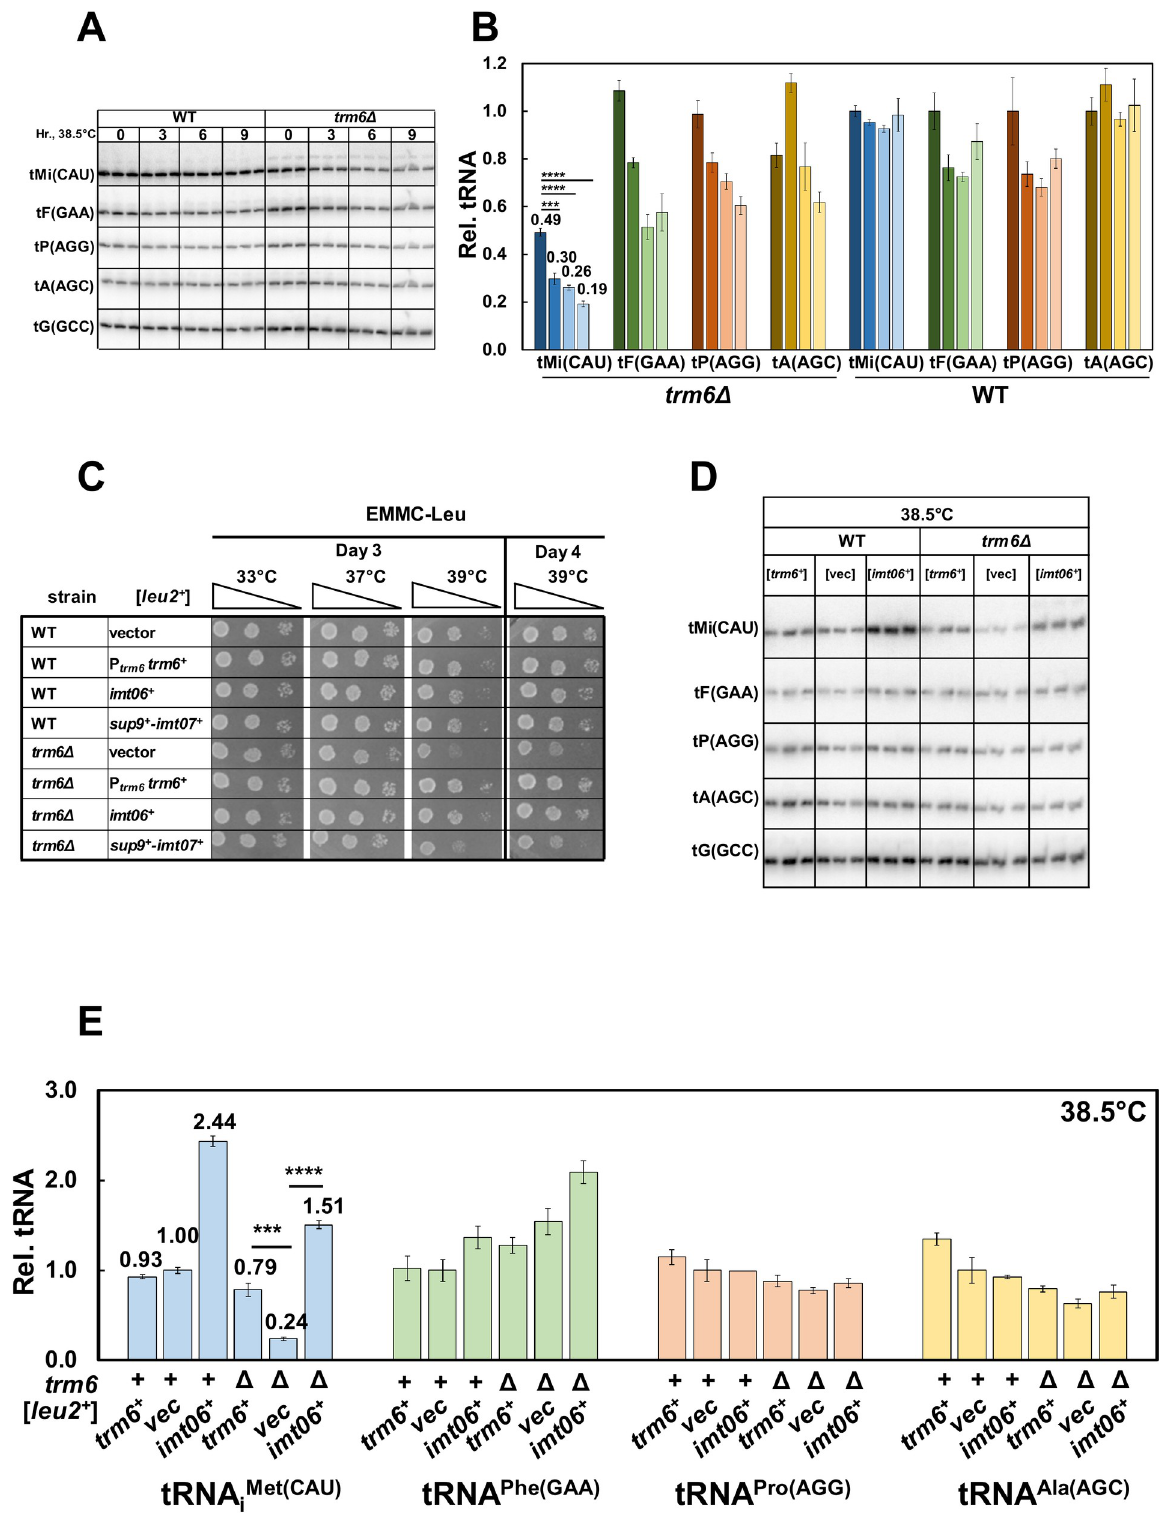
Fig 2. S . pombe trm6 Δ temperature sensitivity is associated with reduced tRNA iMet(CAU) levels. (A) Northern analysis of tRNAs in S . pombe trm6 Δ and WT cells before and after shift from 30˚C to 38.5˚C. Strains were grown in YES media at 30˚C, shifted to 38.5˚C for 9 hours as